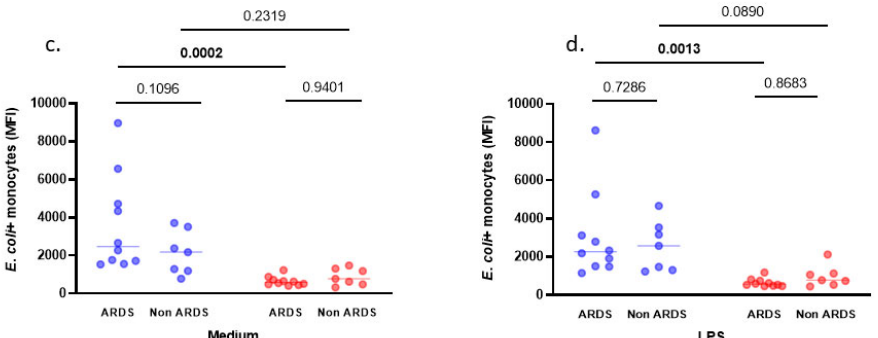
Figure 5. Phagocytosis of E. coli particles by alveolar and blood monocytes measured by flow cytometry. The phagocytosis activity of alveolar and blood monocytes has been measured with and without (medium condition) LPS challenge and expressed in percentage of positive cells (%) ( a , b ) and in mean fluorescence intensity (MFI) ( c , d ) in ten pneumonia-related ARDS and seven non-ARDS patients. Phagocytosis activity was analyzed by two-way ANOVA with repeated measures. When results were expressed in %, there was no significant effect of compartment (BAL fluid vs. blood, p = 0.1087) and neither significant effect of group (ARDS vs. non-ARDS, p = 0.5264) nor significant interaction (group x compartment, p = 0.4903) in medium condition ( a ). After LPS challenge ( b ), there was a significant effect of compartment (BAL fluid vs. blood, p = 0.0361) but there was no significant effect of group (ARDS vs. non-ARDS patients, p = 0.1397), nor significant interaction (group x compartment, p = 0.7593). When results were expressed in MFI, there was a significant effect of compartment (BAL fluid vs. blood, p = 0.0003) but neither significant effect of group (ARDS vs. non-ARDS, p = 0.2469) nor significant interaction (group x compartment, p = 0.1145) in medium condition ( c ). After LPS challenge ( d ), there still was a significant effect of compartment (BAL fluid vs. blood, p = 0.0010) but there was neither significant effect of group (ARDS vs. non-ARDS patients, p = 0.8645) nor significant interaction (group x compartment, p = 0.4072). Displayed p -values come from post-hoc comparisons performed using the Sidak’s test. Bolded p values are significant at the <0.05 level. Horizontal bars represent median values.